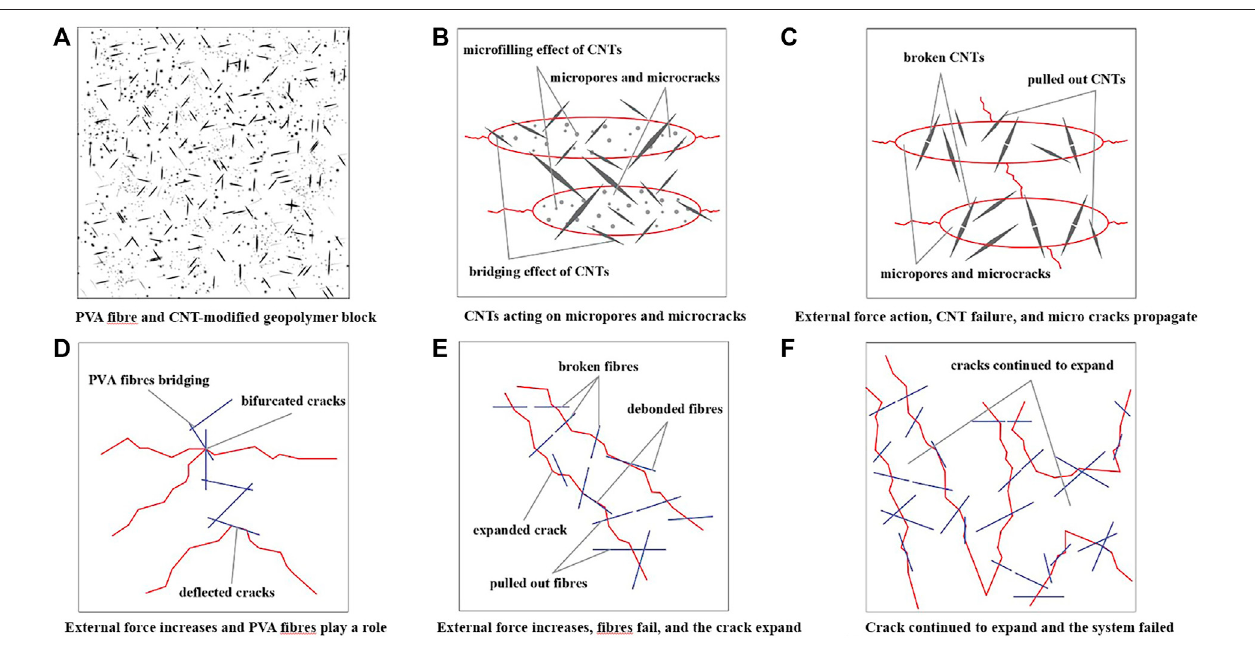
FIGURE 11 | Multi-scale mechanism of dual- fi bre strengthening